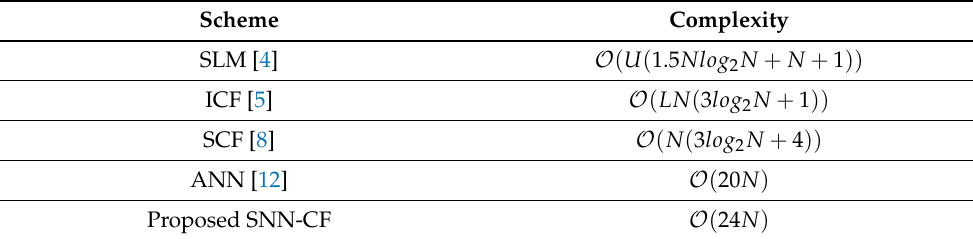
Table 1. Complexity requirements of the investigated schemes.